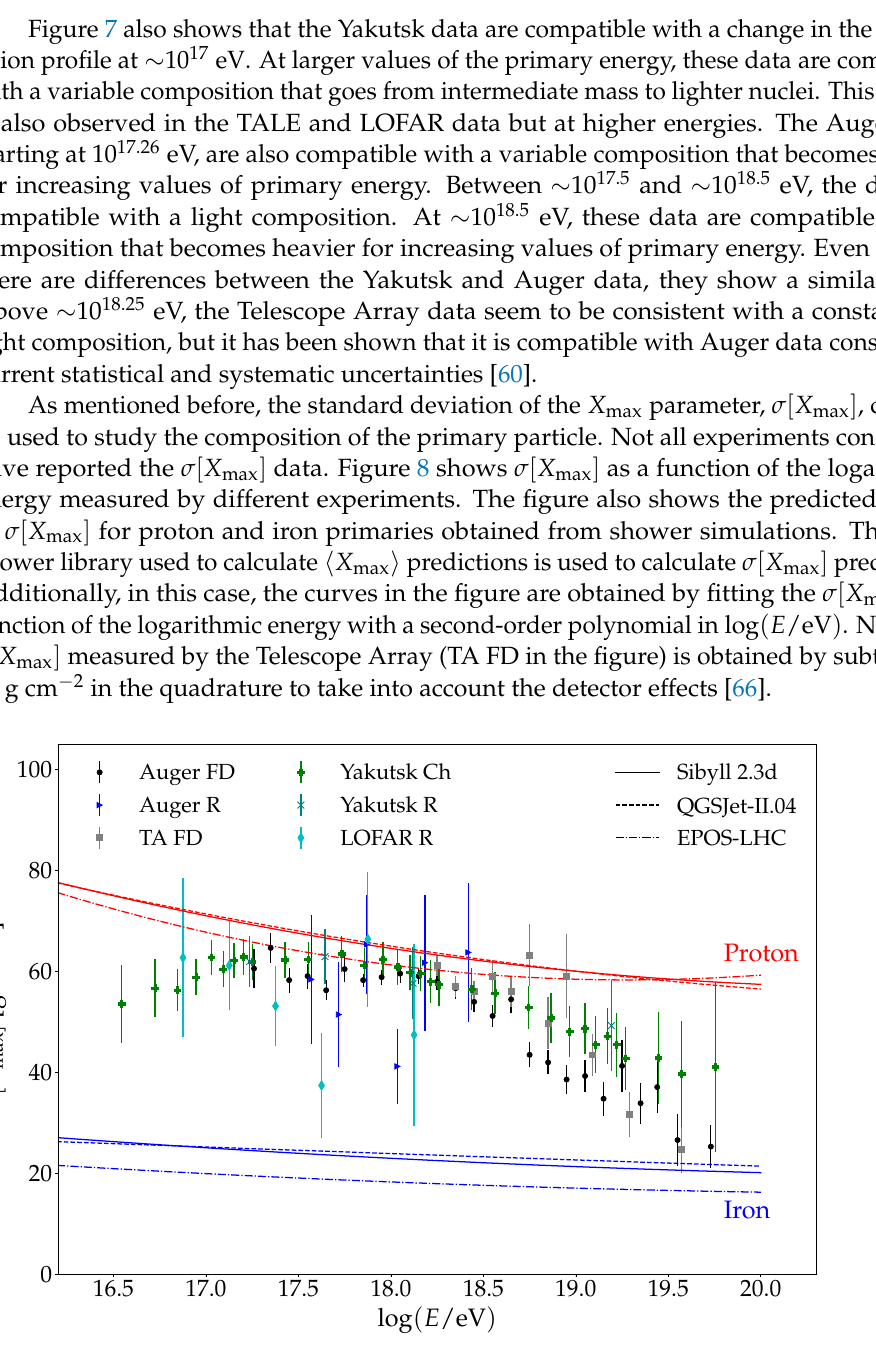
Figure 8. Standard deviation of X max as a function of logarithmic energy measured by different experiments. FD, Ch, and R in the legend refer to fluorescence, Chrerenkov, and radio techniques, respectively. The data of Auger are labeled as: Auger FD [61] and Auger R [56]. The data of Telescope Array are labeled as: TA FD [63]. The data of Yakutsk are labeled as: Yakutsk Ch [50] and Yakutsk R [57]. The data of LOFAR are labeled as: LOFAR R [59]. The curves correspond to model predictions for proton and iron primaries simulated by using different high-energy hadronic interaction